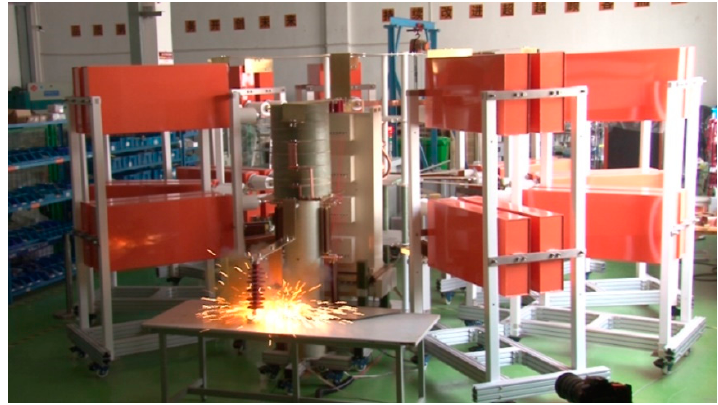
Figure 9. Lighting protection test.